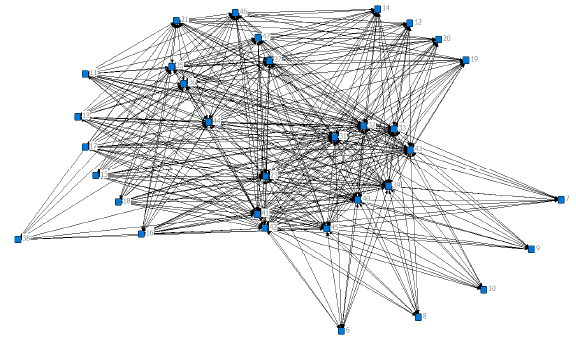
Figure 1. Unweighted network diagram of air transportation.